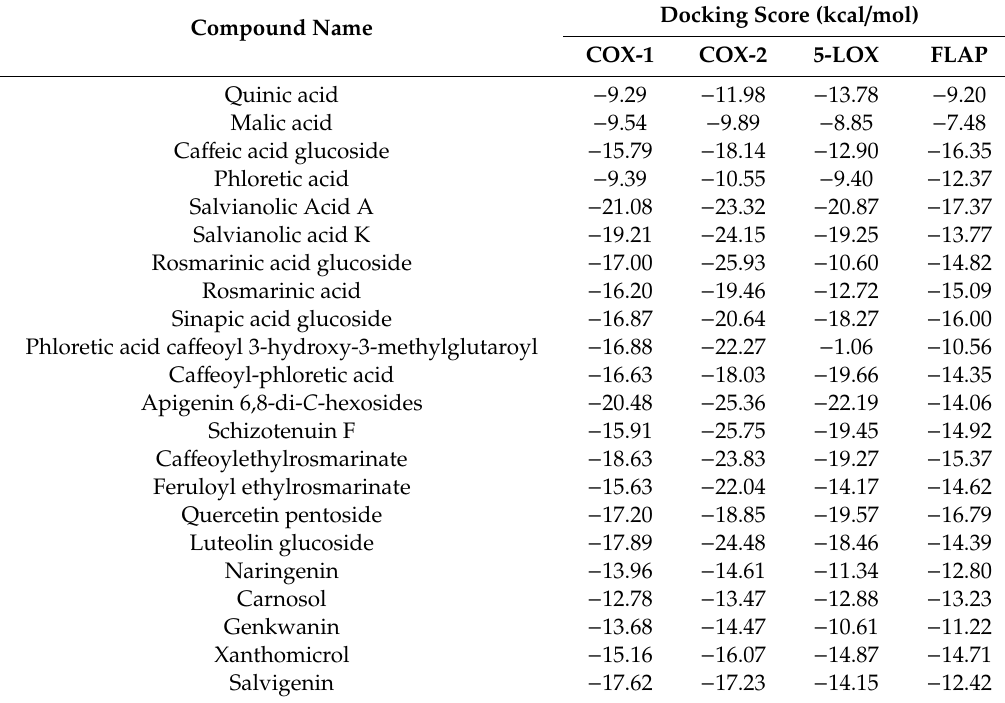
Table 4. Docking scores retained from positioning selected compounds of T. algeriensis and T. fontanesii extracts into the binding sites of COX-1, COX-2, 5-LOX, and 5-Lipoxygenase Activating Protein